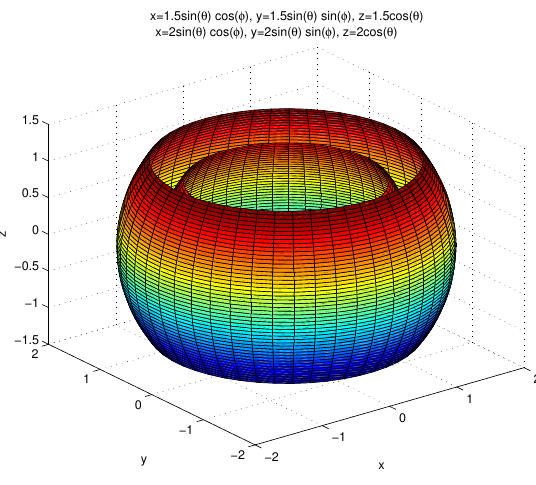
Figure 1. The special bounded domain ˜ Ω